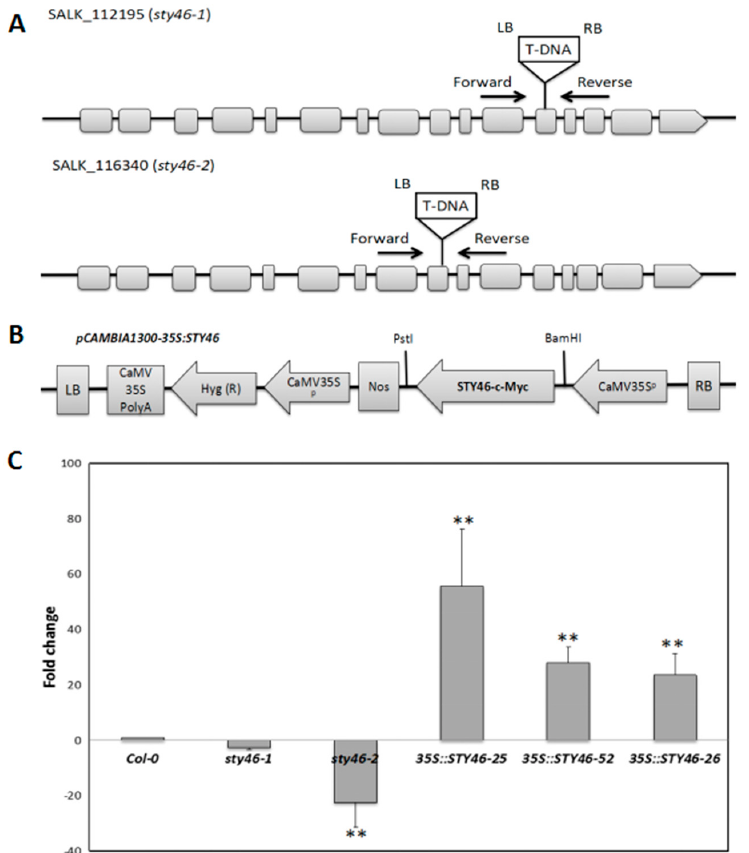
Figure 2. Generation of stable STY46 transgenic lines. ( A ) A gene model showing the position of the T-DNA insertion. Two stable homozygous STY46-mutant lines: STY46-1 (SALK_112195, T-DNA insertion in the 12th exon) and STY46-2 (SALK_116340, T-DNA insertion in the 9th exon). ( B ) Schematic diagram of the STY46 overexpressing construct. Left border (LB); CaMV35SPolyA: Untranslated region of CaMV 35S gene; Hyg (R): Hygromycin phosphotransferase gene that confers Hygromycin resistance; CaMV35S p : CaMV 35S promoter; NOS: transcriptional terminator sequence of the nopaline synthase gene; STY46-c-Myc: a c-Myc-epitope-tagged full-length cDNA of STY46; right border (RB). ( C ) qRT-PCR showing relative amounts of mRNA levels in STY46 knockout (KO), and overexpressing (OE) lines. Average qPCR data were derived from nine data measurements for each sample. Error bars represent the standard deviation. The asterisks indicate the statistically significant di ff erences of transcripts levels between genes in the control and stress-treated plants ( n = 3, ‘*’, 0.01 < p < 0.05; ‘**’, 0.001 < p < 0.01; ‘***’, 0 < p < 0.001).